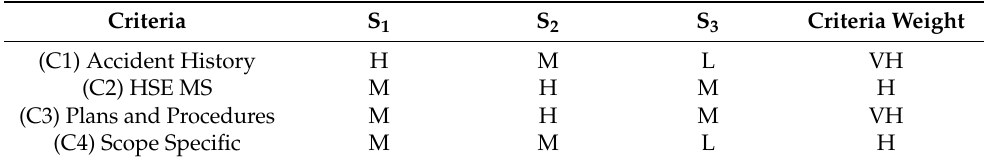
Table 7. Supplier performance evaluation.